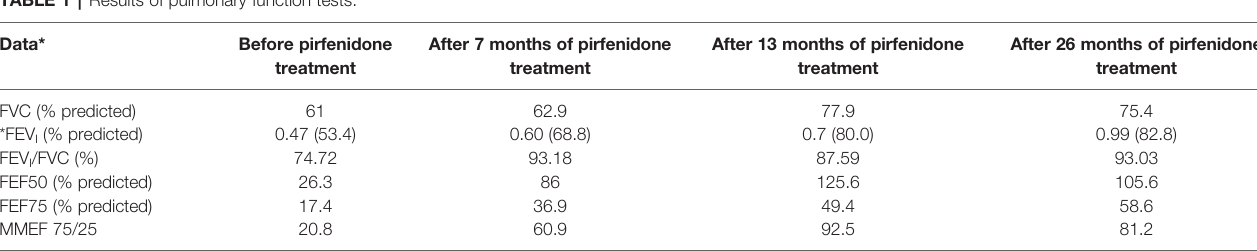
TABLE 1 | Results of pulmonary function